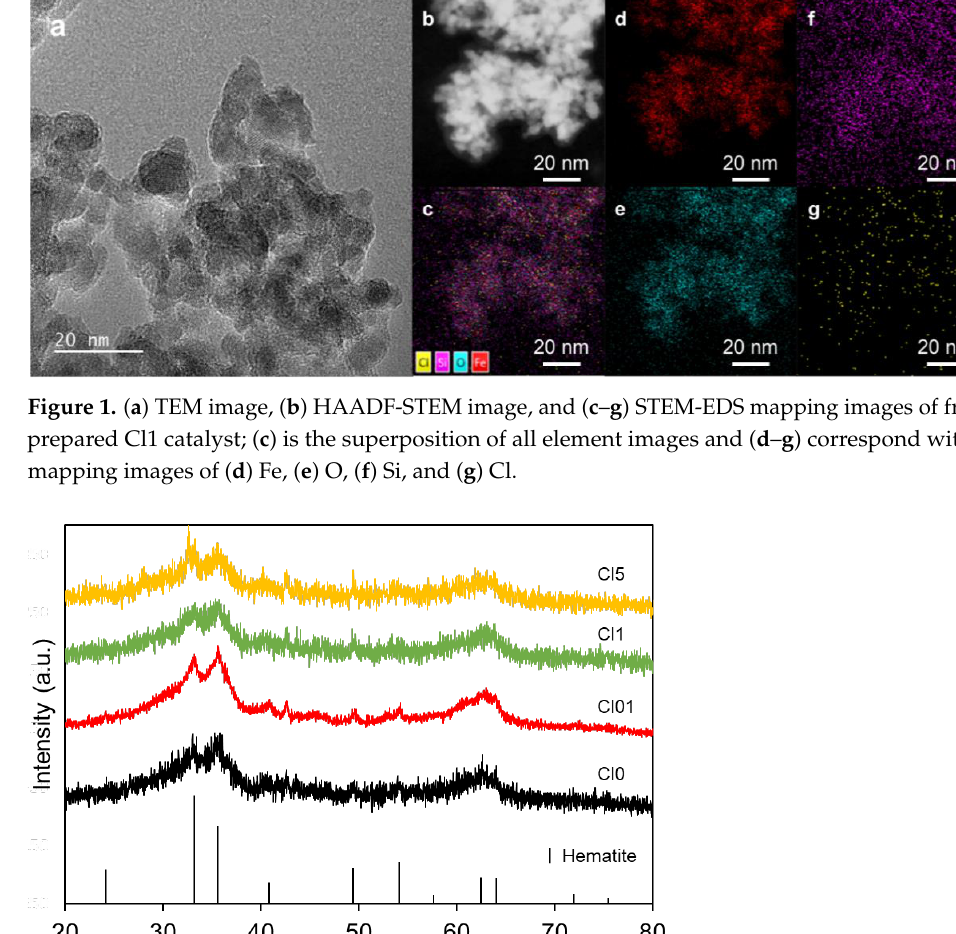
Figure 2. XRD patterns of freshly prepared precipitated iron catalysts with chlorine.